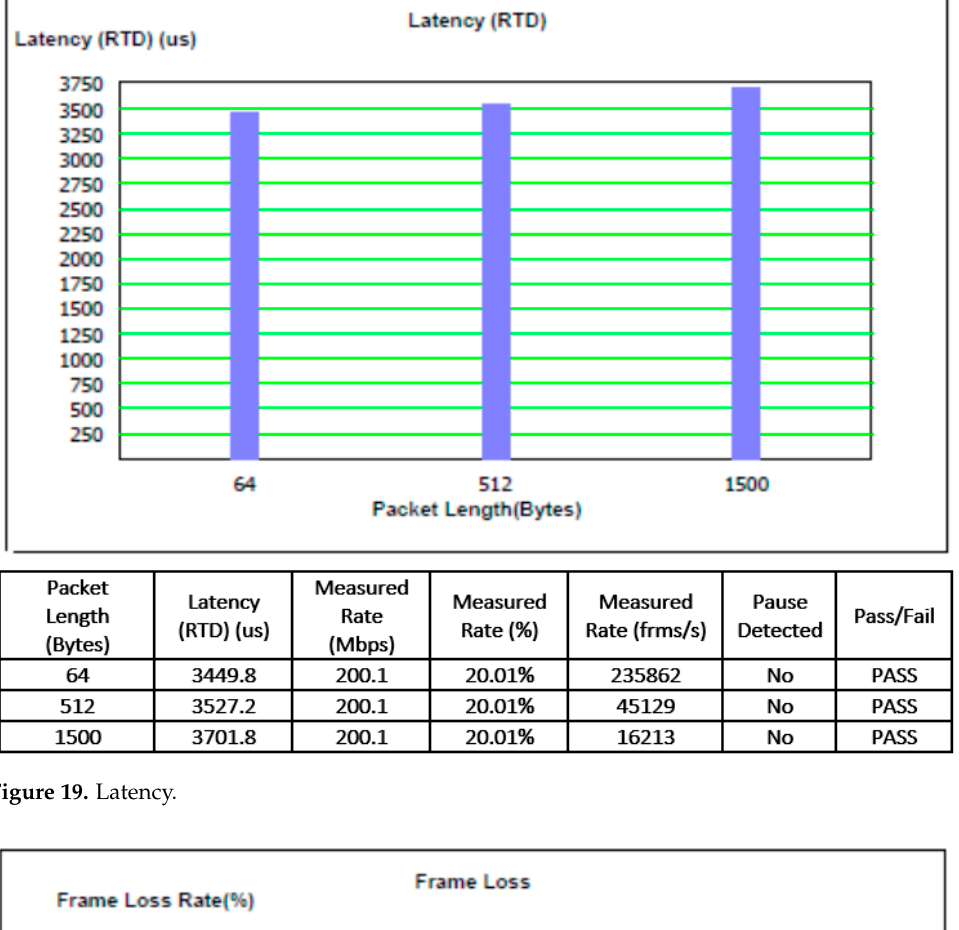
Figure 18. Throughput.